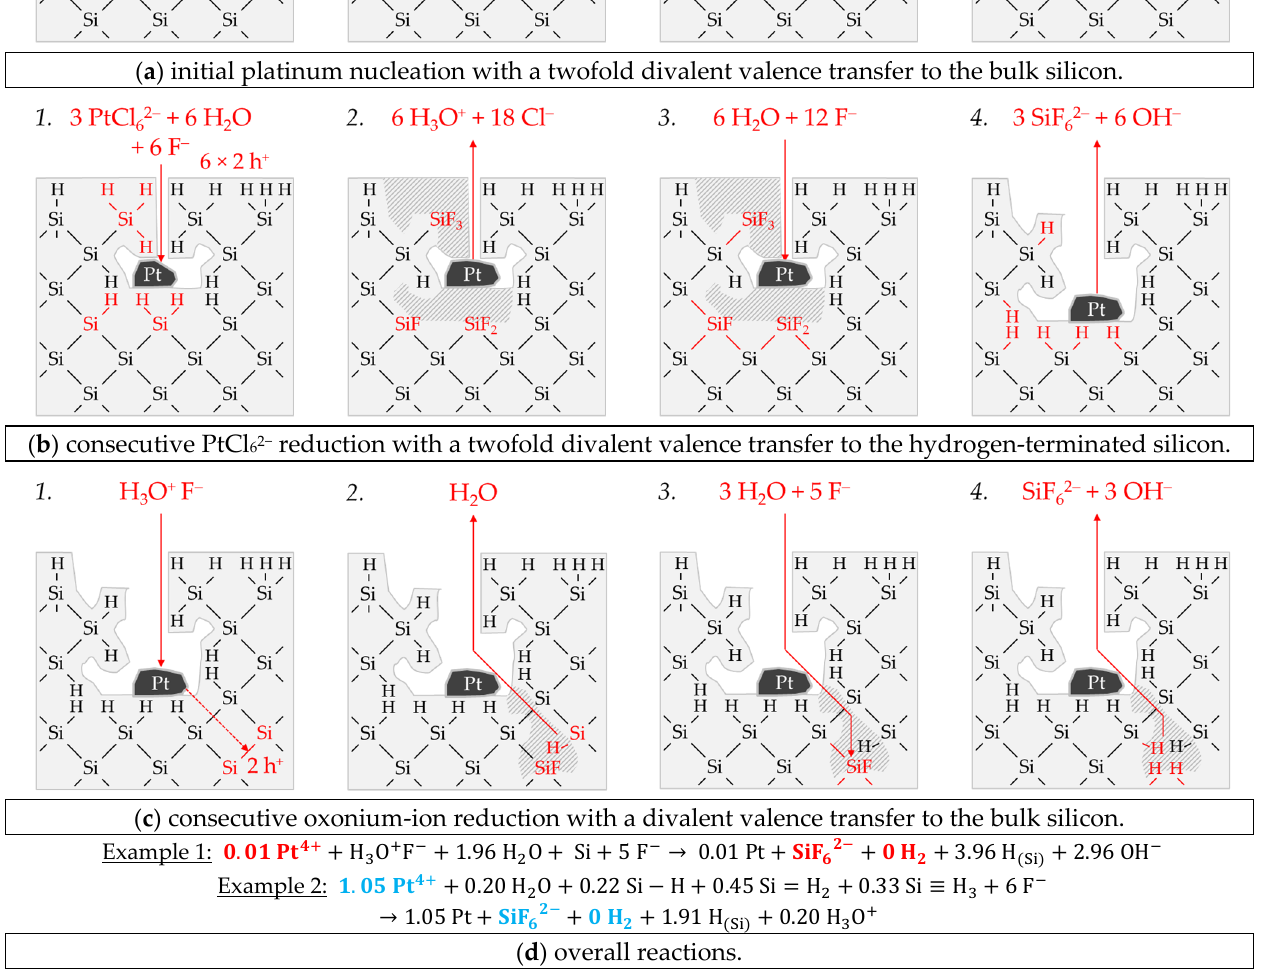
Figure 11. Schematic reaction process and balance of the platinum deposition on silicon, based on the examples marked in Figure 10e,f, showing ( a ) the initial platinum deposition, ( b ) the consecutive PtCl 62 − reduction, ( c ) the consecutive oxonium-ion reduction if Eq. Pot. (2H 3 O + /H 2 ) ≥ 0 V vs. SHE and ( d ) balances of the overall reactions of examples 1 and 2.